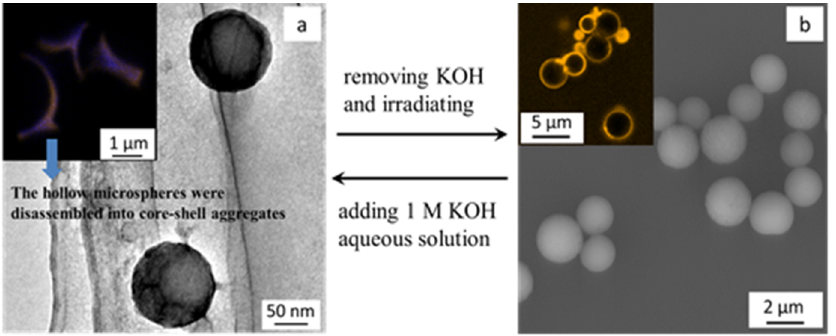
Figure 3. The TEM image of the core-shell aggregates obtained from the disassembly of the hollow microspheres in 1 mol L − 1 KOH aqueous solution (the inset of 3a is the CLSM image of the hollow microspheres in 1 mol L − 1 KOH aqueous solution) ( a ), and the SEM and CLSM (the inset of 3b) images of the hollow microspheres obtained by irradiating core-shell am-DCH18C6 for 56 h after removing KOH ( b ).